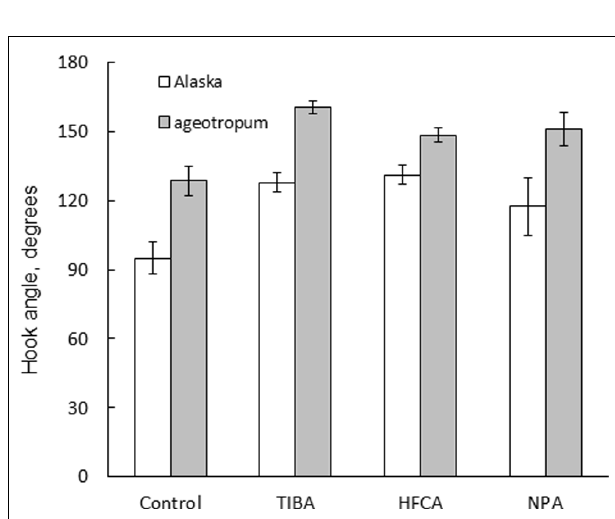
conditions for 96 h asw. Plain water controls were grown under 1- g conditions and also on the 3-D clinostat. To indicate the seed axis the needle was set up in the gap between the cotyledons prior to photographing.